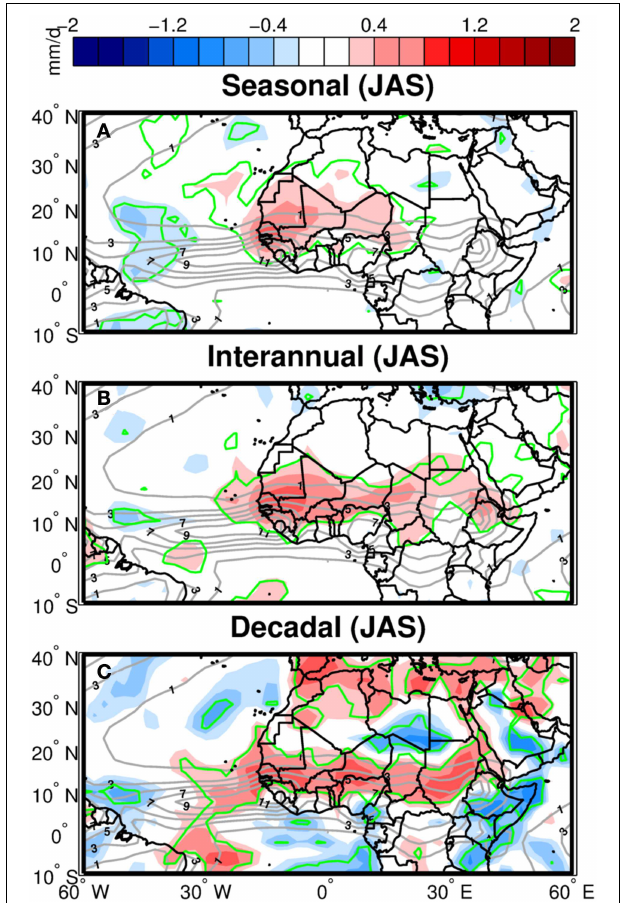
FIGURE 5 | Spatial regression (in mm/day) in summer (JAS) between rainfall in the Saloum region and over the rest of the domain for (A) Seasonal, (B) Interannual, and (C) Decadal timescale. Green contours delimit areas where the regression is significant at 95% level using a Monte Carlo simulation. Gray contours represent the mean climatological (JAS) rainfall (mm/d).